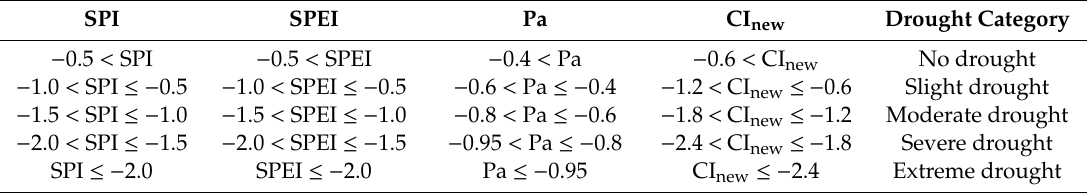
Table 2. Drought grades based on SPI, SPEI, Pa and CI new